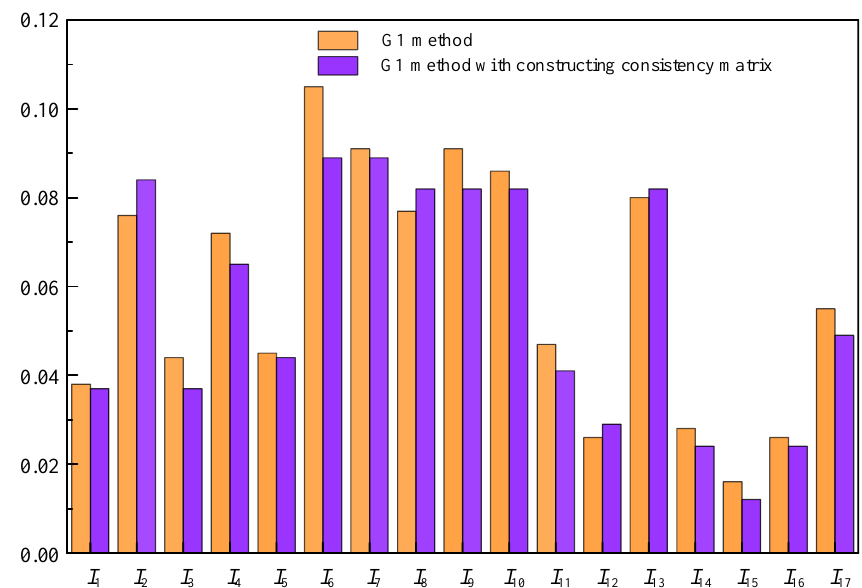
Figure 3. Three-level indicators weight calculation results of both